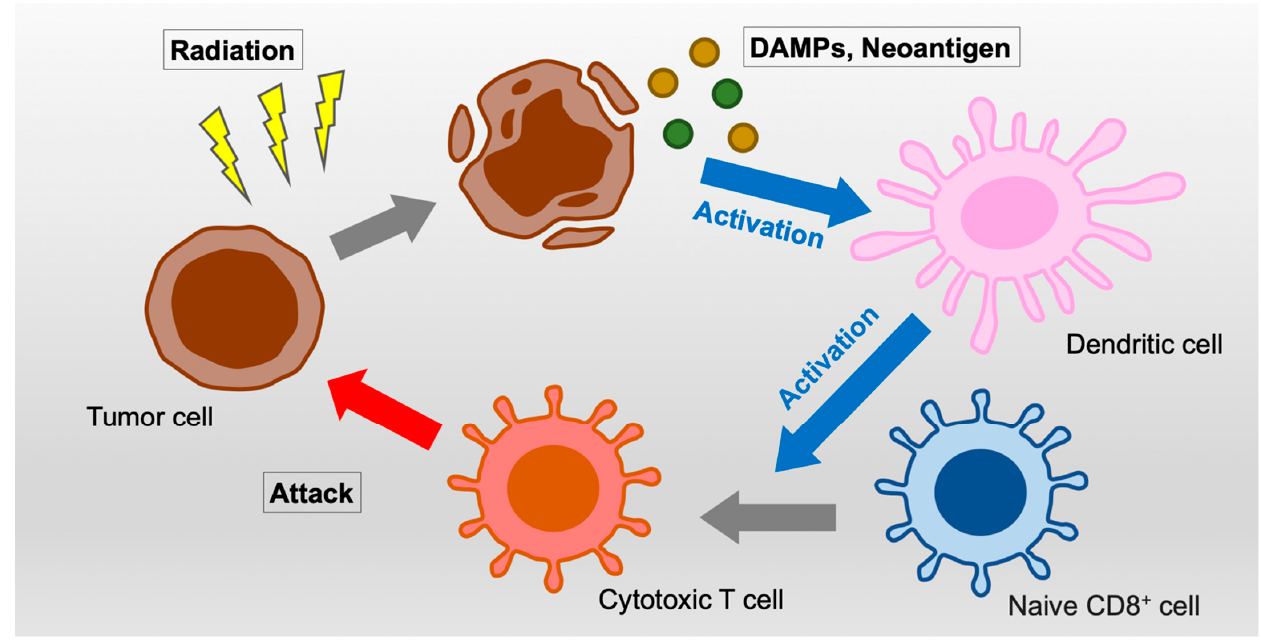
Figure 1. Schema of immune activation by irradiation. Abbreviation: DAMPs, damage-associated molecular patterns.